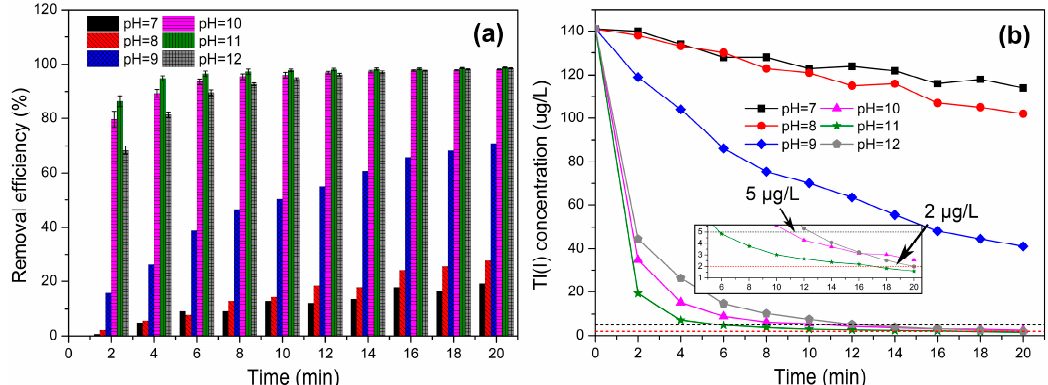
Figure 2. E ff ect of initial pH on ( a ) removal e ffi ciency, ( b ) concentration of Tl(I) within a 20 min EC treatment under an applied current density of 16.7 mA / cm 2 with aeration of 0.2 L / min, using Fe–Fe electrodes at a distance of 2 cm. C 0 = 141 µ g /